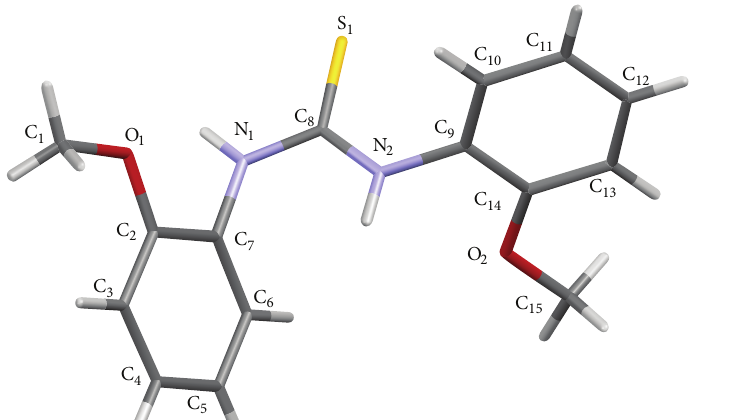
Figure 1: The capped sticks diagram of 1,3-bis(2-methoxyphenyl) thiourea. Selected bond lengths (˚A) and angles (deg.): S 1 –C 8 (1.690(2)), N 1 – C 8 (1.352(2)), N 2 –C 8 (1.342(3)), N 1 –C 7 (1.429(2)), N 2 –C 9 (1.432(3)), O 1 –C 1 (1.426(3)), O 1 –C 2 (1.367(3)), O 2 –C 14 (1.370(3)), O 2 –C 15 (1.429(3)),